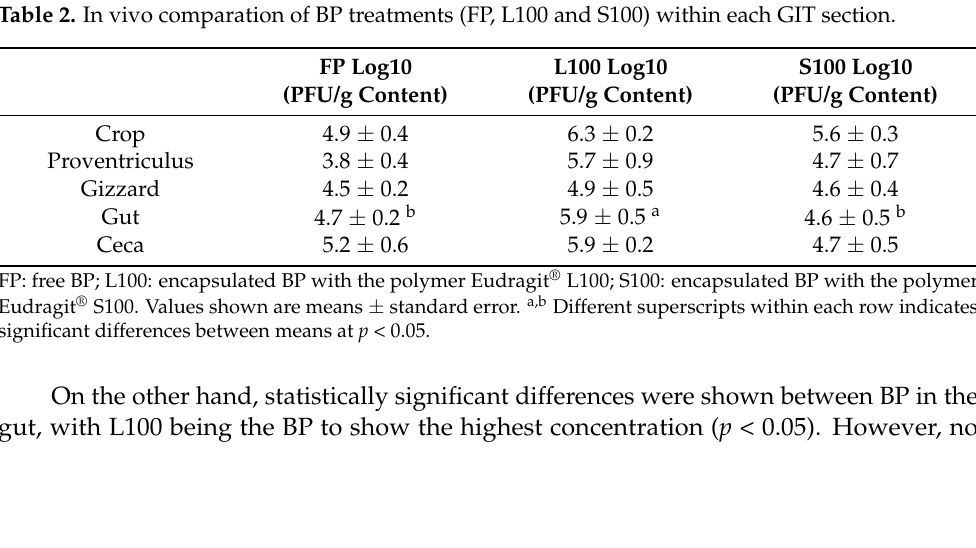
Table 2. In vivo comparation of BP treatments (FP, L100 and S100) within each GIT section.